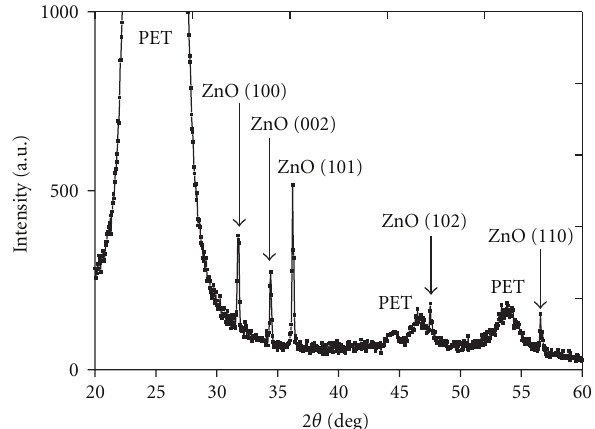
Figure 1: XRD patterns of ZnO thin films on PET substrates.